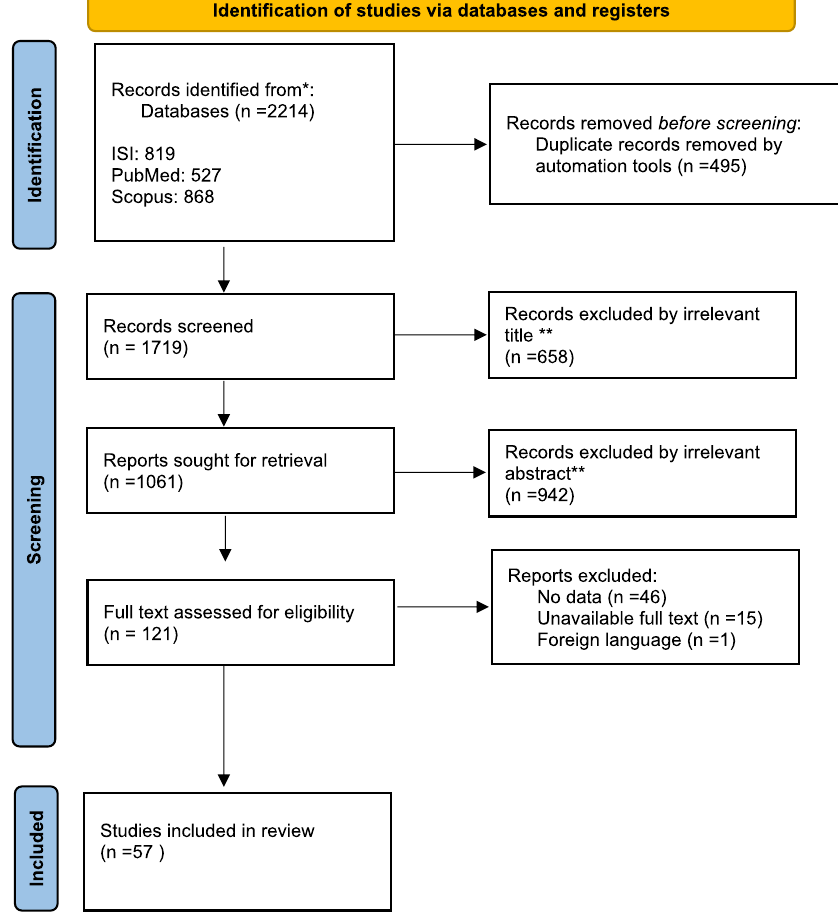
Figure 1. Flow diagram of the literature search for studies included in